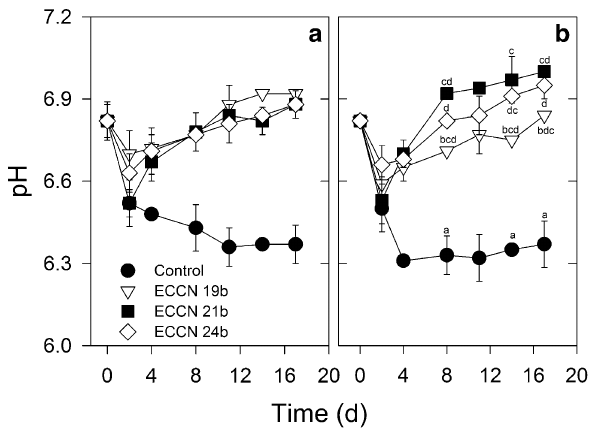
Fig. 2 Time course of the change in pH of minimal salt medium containing either coal discard ( a ) or geologically weathered coal ( b ) after inoculation with either Citrobacter strain ECCN 19b, Exiguobacterium strain ECCN 21b, and Serratia strain ECCN 24b. All data are the mean ± SE ( n = 6) of three determinations and are representatives of duplicate experiments